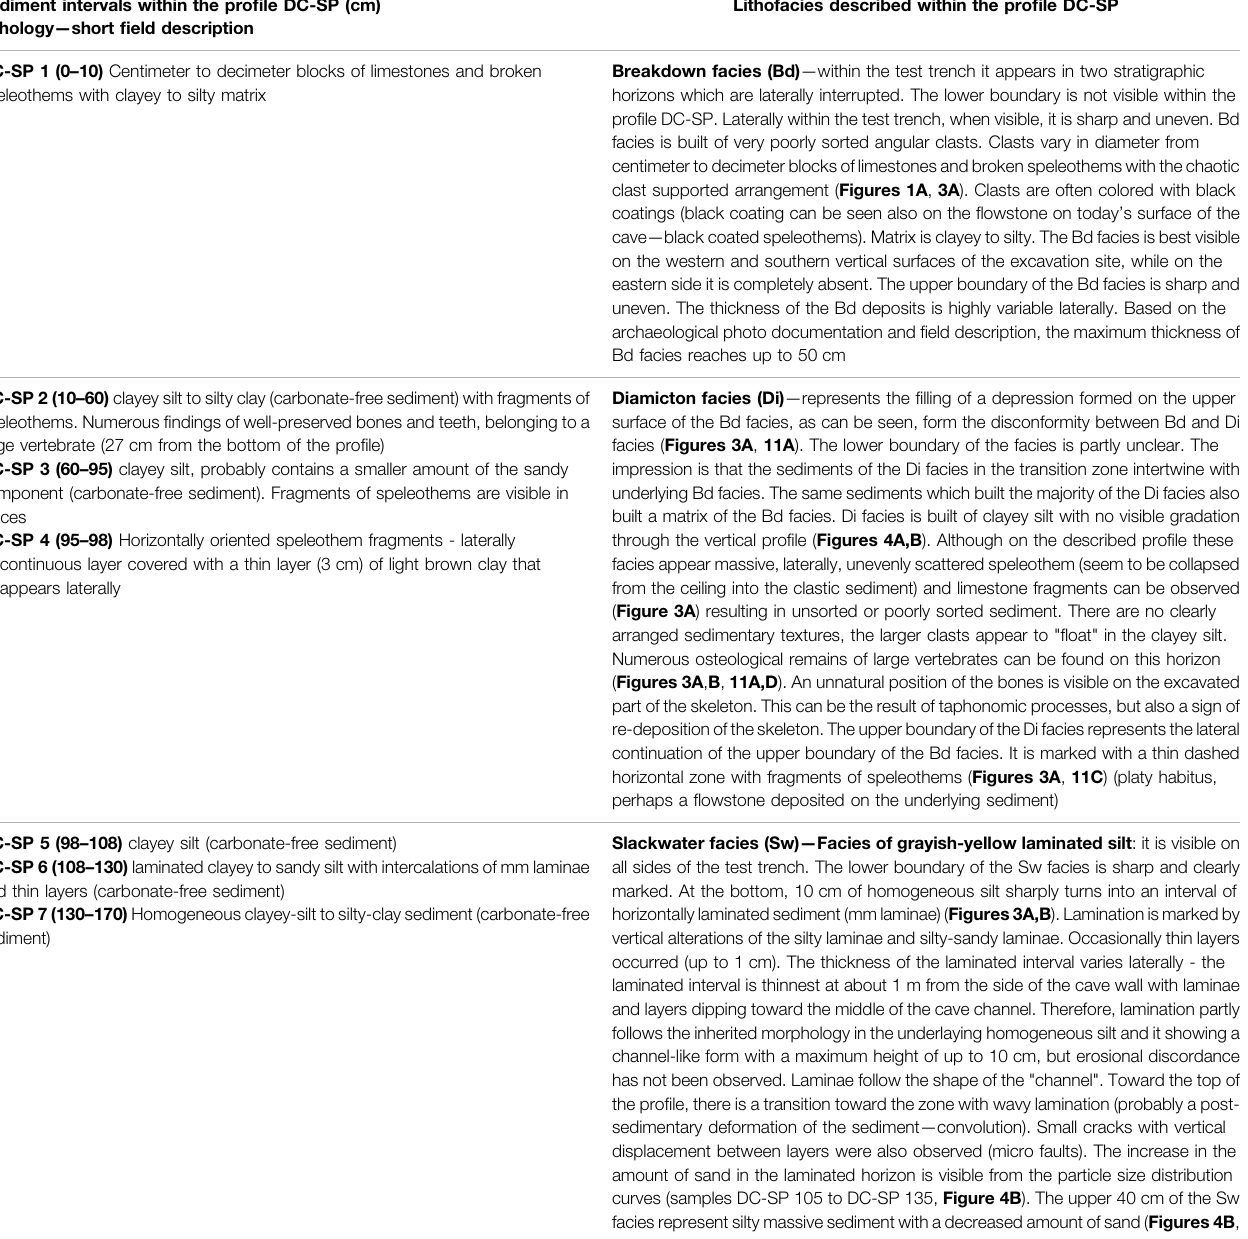
Lithofacies described within the pro fi le